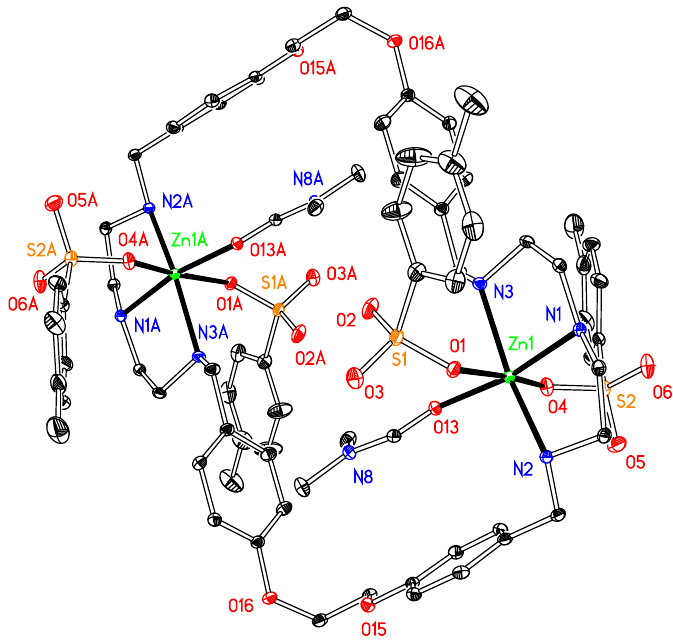
Figure 2. Thermal ellipsoid plot, drawn at the 50% probability level, of [Zn 2 ( p -OSO 2 PhCH 3 ) 4 L 1 ] ( 2 ) with atomic numbering scheme. All H atoms, along with DMF, C 4 H 8 O 2 , are omitted for clarity. Symmetry codes: A 1 − x, 1 − y, − z. Selected bond lengths (Å) and angles ( ◦ ): Zn1-N1 2.122(18), Zn1– N2 2.168(2), Zn1-N3 2.182(2), Zn1–O1 2.4094(19), Zn1–O4 2.086(2); Zn1–O13 2.0390(18); N1–Zn1–N2